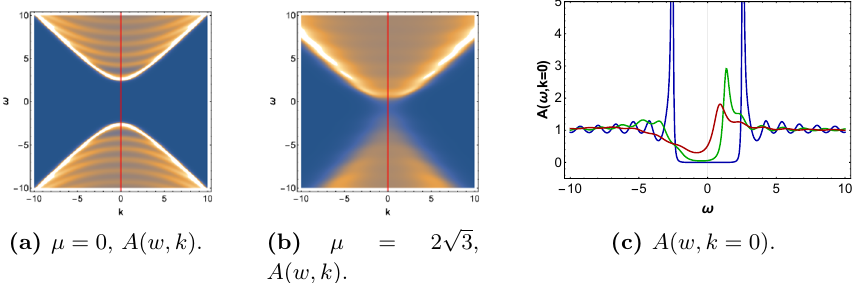
Figure 16. The role of µ for the case with scalar condensation: (a) without and (b) with chemical potential. (c) Spectrum at k = 0 : blue for µ = 0 , green for µ =